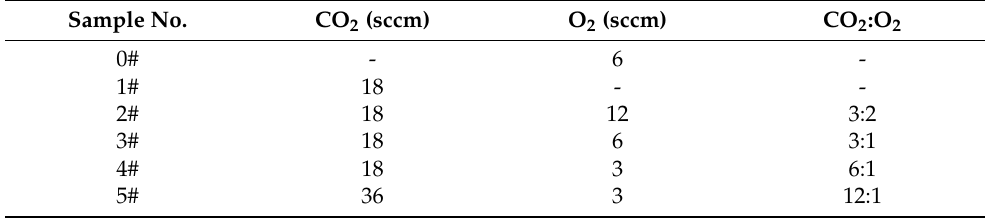
Table 1. Basic process parameters of reactive magnetron sputtering deposition. Sample